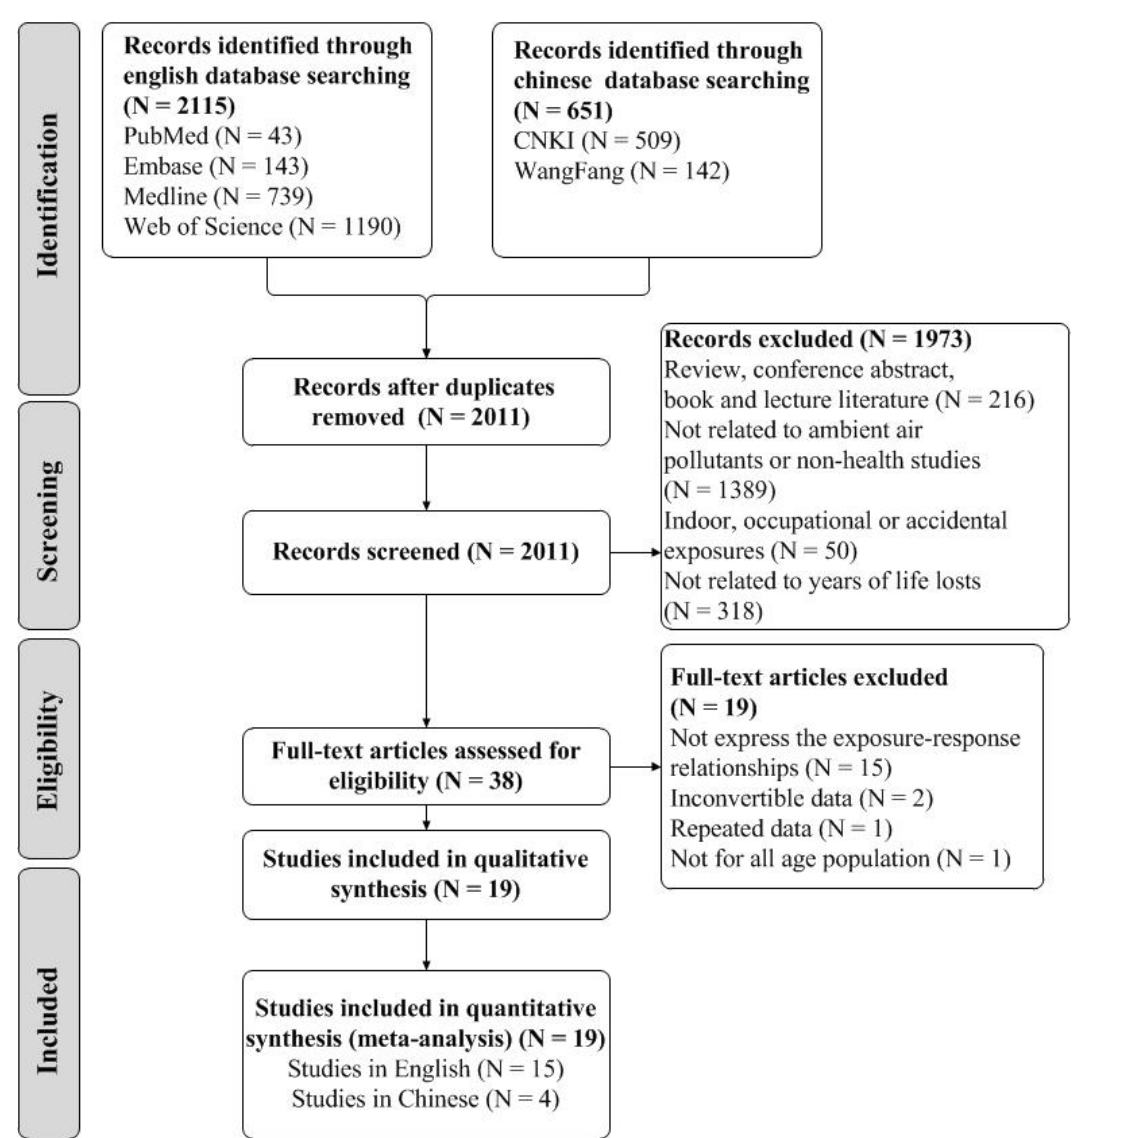
Figure 1. Flowchart of literature for search and identification.